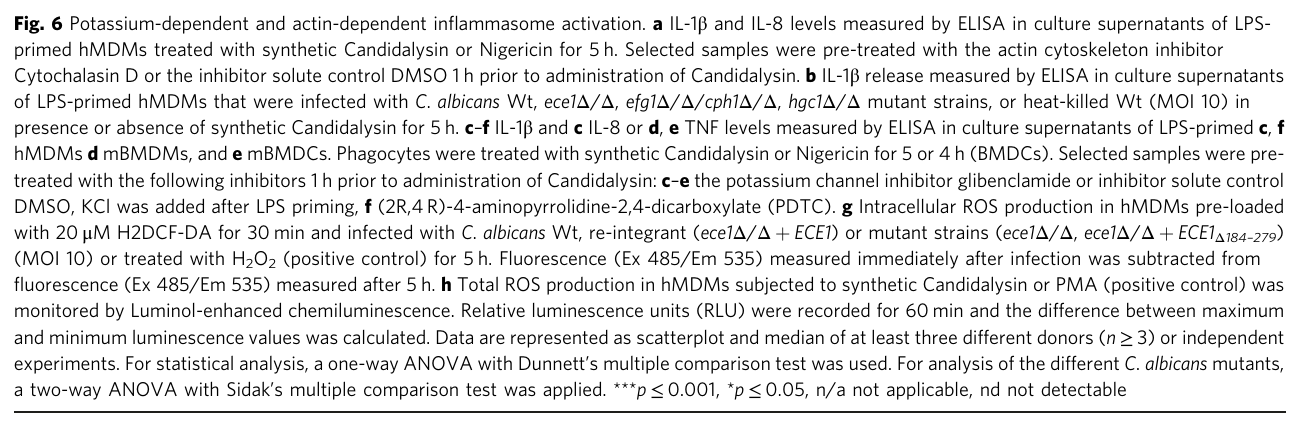
Fig. 6 Potassium-dependent and actin-dependent in fl ammasome activation. a IL-1 β and IL-8 levels measured by ELISA in culture supernatants of LPS- primed hMDMs treated with synthetic Candidalysin or Nigericin for 5 h. Selected samples were pre-treated with the actin cytoskeleton inhibitor Cytochalasin D or the inhibitor solute control DMSO 1 h prior to administration of Candidalysin. b IL-1 β release measured by ELISA in culture supernatants of LPS-primed hMDMs that were infected with C . albicans Wt, ece1 Δ / Δ , efg1 Δ / Δ / cph1 Δ / Δ , hgc1 Δ / Δ mutant strains, or heat-killed Wt (MOI 10) in presence or absence of synthetic Candidalysin for 5 h. c – f IL-1 β and c IL-8 or d , e TNF levels measured by ELISA in culture supernatants of LPS-primed c ,